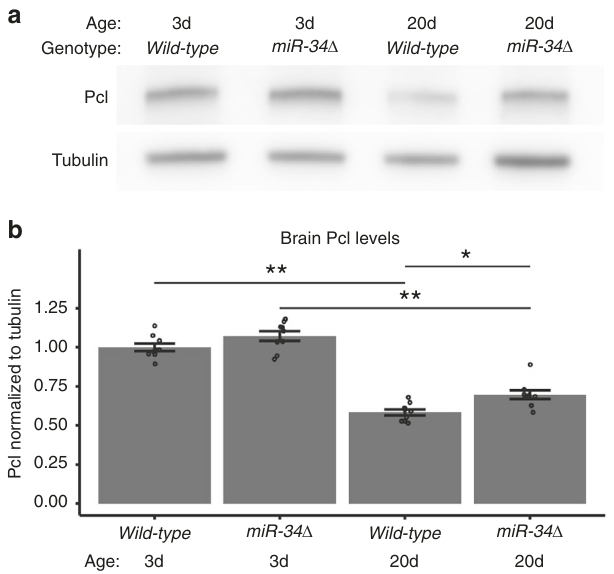
Fig. 2 Pcl is a target of miR-34 in the brain. a , b Pcl protein levels are deregulated in miR-34 mutants. a Western immunoblots. b Quantitation of immunoblots. Pcl levels decrease with age in both wild-type and miR-34 mutants. Pcl levels were higher than wild-type control at 20d. Protein samples from dissected brains. Western immunoblot, with tubulin as the loading control. Pcl protein levels are normalized to tubulin. Mean± SEM, n = 9 biological replicates. Signi fi cant main effects were observed (genotype: F 1,32 = 12.7, p < 0.01 age: F 1,32 = 232, p < 0.001). (* p < 0.05, ** p < 0.01,